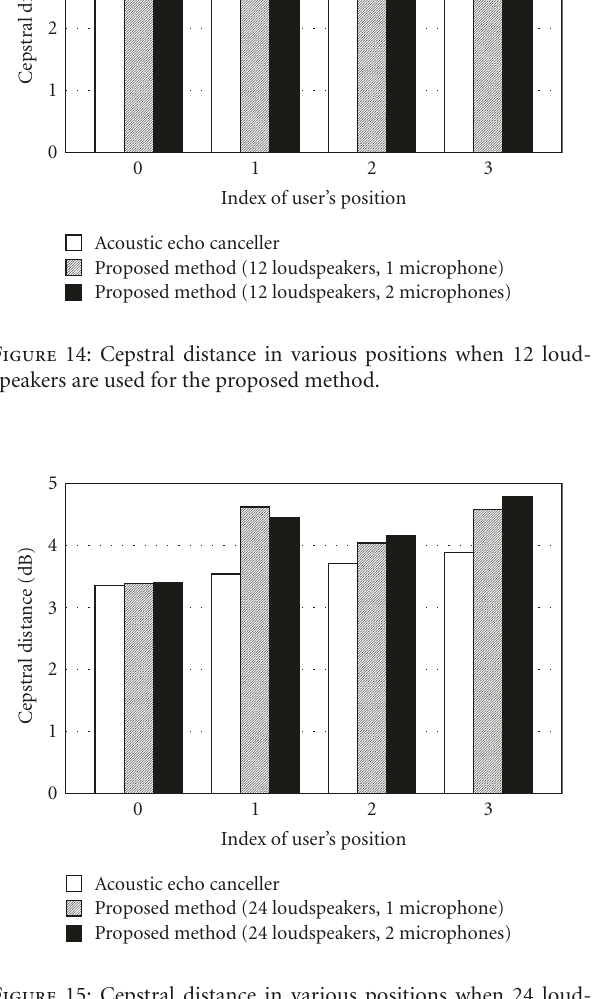
Figure 15: Cepstral distance in various positions when 24 loud- speakers are used for the proposed method.